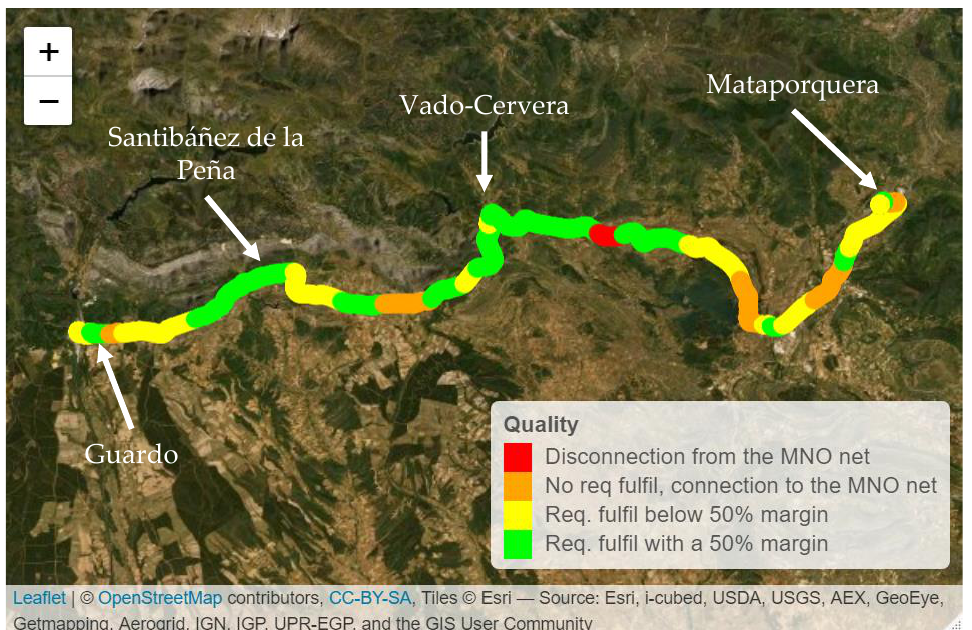
Figure 9. Field measurements along the Guardo–Mataporquera section from Guardo–Balmaseda Railway